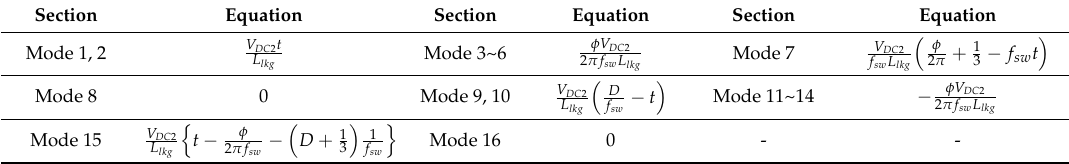
Table 2. Current equation of the secondary side phase A transformer depending on